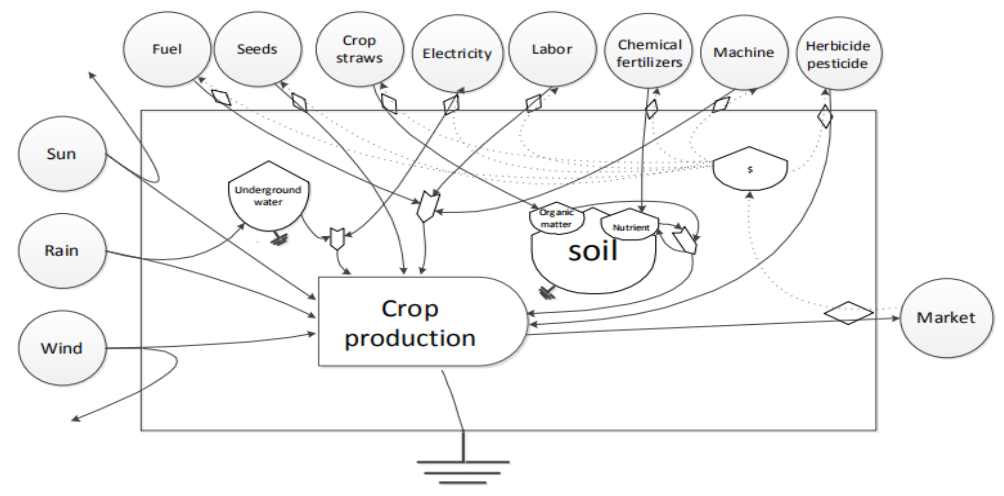
Figure 1. Energy flow diagram of the cropping system. means a compartment of energy storage; represents source of energy; means producer; is the flow of material; is the flow of money.